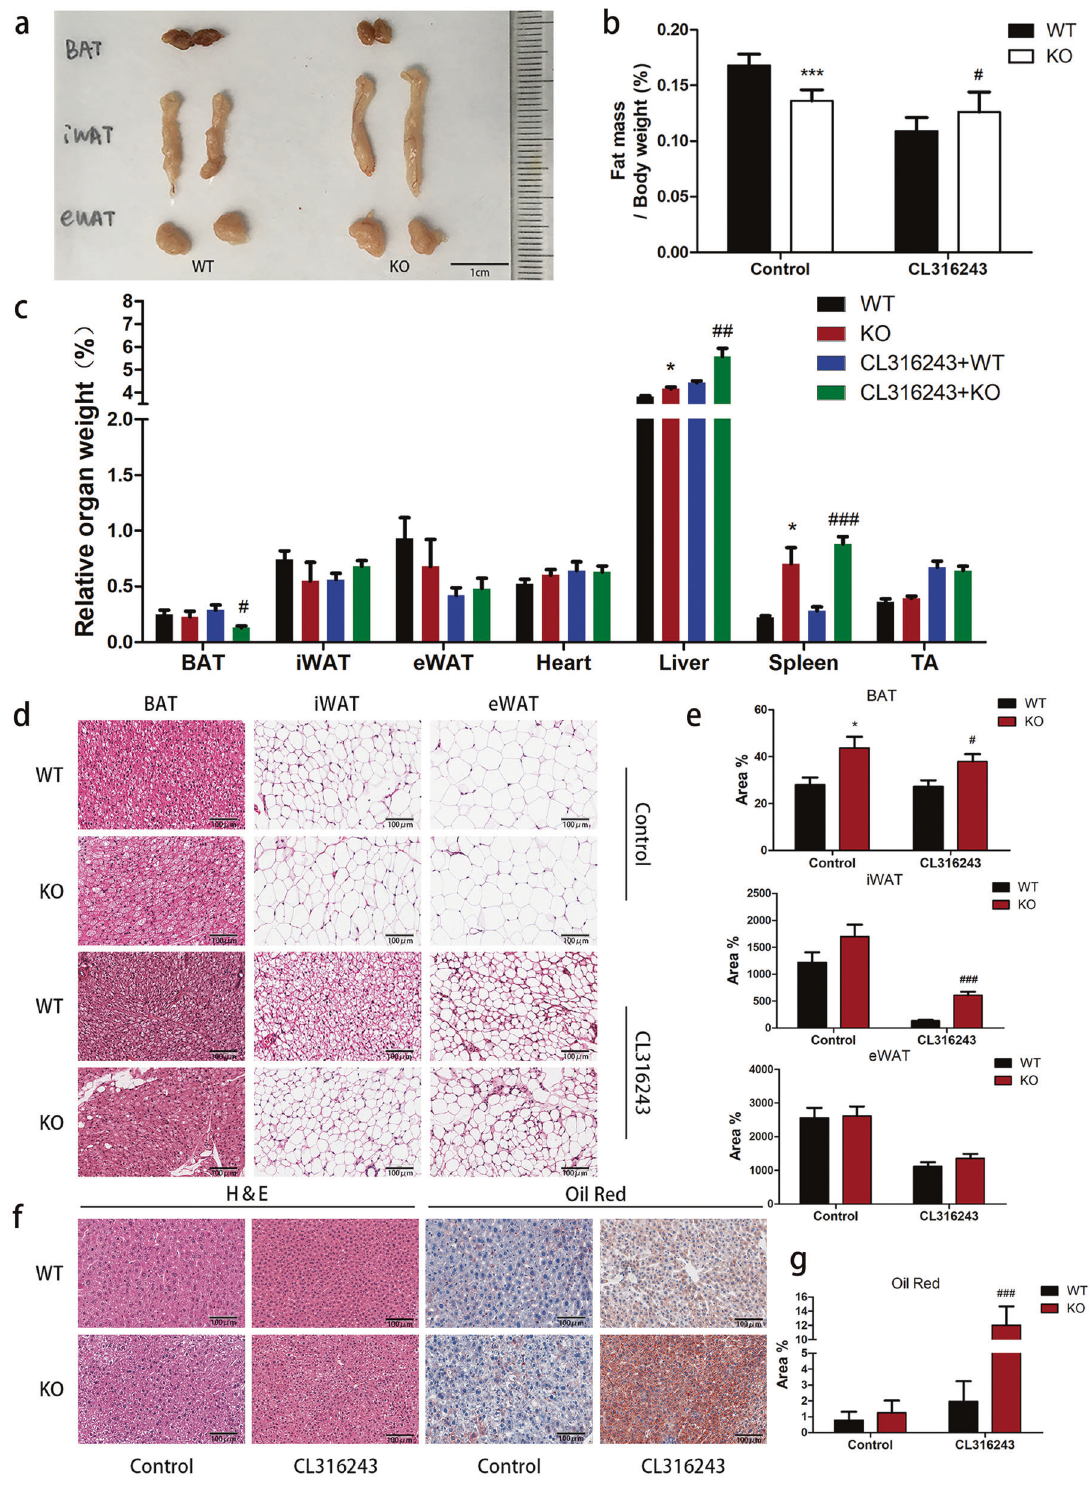
Fig. 2 Decreased thermogenesis in Trib1 -knockout mice. a Representative adipose tissue image of Trib1 -knockout mice. Body composition ( b ) and ratio of tissue weight-to-bodyweight ( c ) of Trib1 KO and WT mice treated with CL316243 or not. Representative hematoxylin and eosin (H&E) staining image ( d ) and adipocyte area ( e ) of BAT, iWAT, and eWAT from Trib1 KO and WT mice treated with CL316243 or not. Scale bar: 100 μ m. Representative hematoxylin and eosin (H&E) staining and oil red O staining image ( f ), and red staining area ( g ) of liver tissue from Trib1 KO and WT mice treated with CL316243 or not. Scale bar: 100 μ m. BAT, brown adipose tissue; iWAT, inguinal white adipocyte tissue; eWAT, epididymal white adipocyte. In the bar fi gure, each data represents mean ± SEM ( n = 5). Indicated comparisons were made using Student ’ s paired t -test, * P < 0.05, ** P < 0.01, *** P < 0.001 over Trib1 WT mice; # P < 0.05, ## P < 0.01, ### P < 0.001 over Trib1 WT mice treated with CL316243.